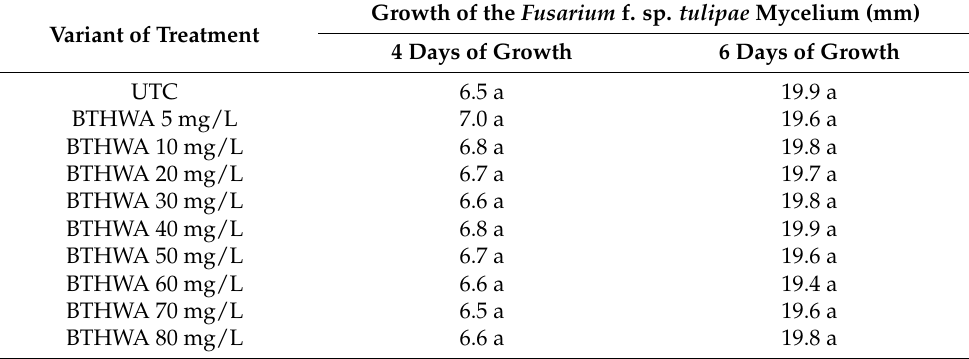
Table 1. The effect of growth on Fusarium oxysporum f. sp. tulipae mycelium on medium with the addition of BTHWA in various concentrations. Variant of